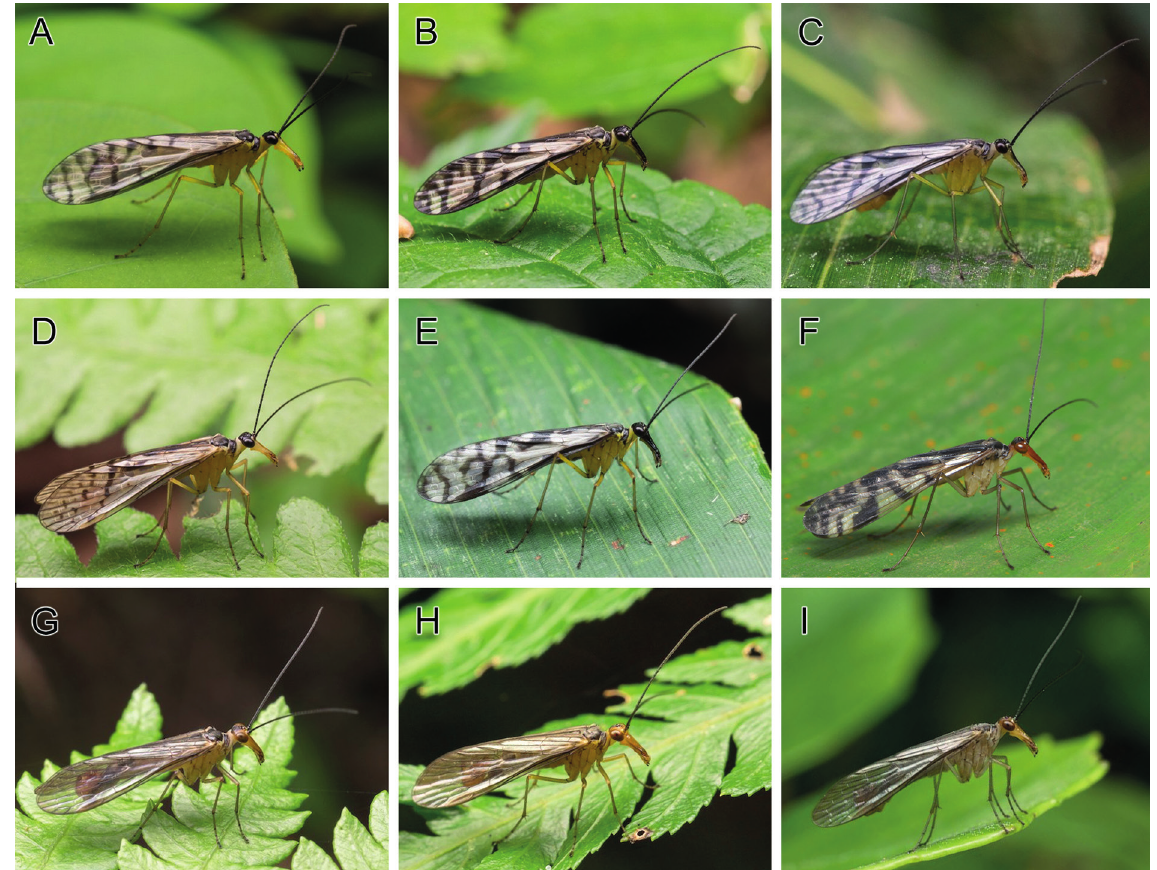
Fig. 1. Habitus of the Panorpa wormaldi group, males. A . Panorpa wormaldi MacLachlan,